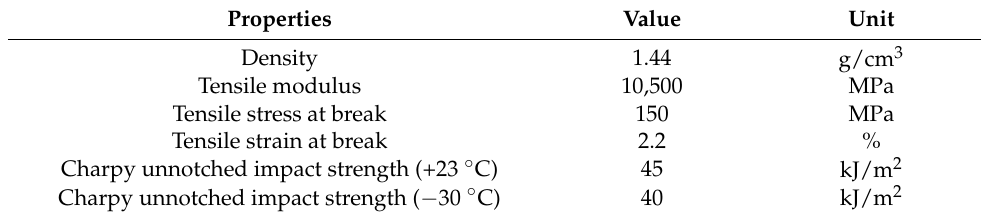
Table 2. Typical properties of ZYTEL ® HTN FR52G30NH NC010.